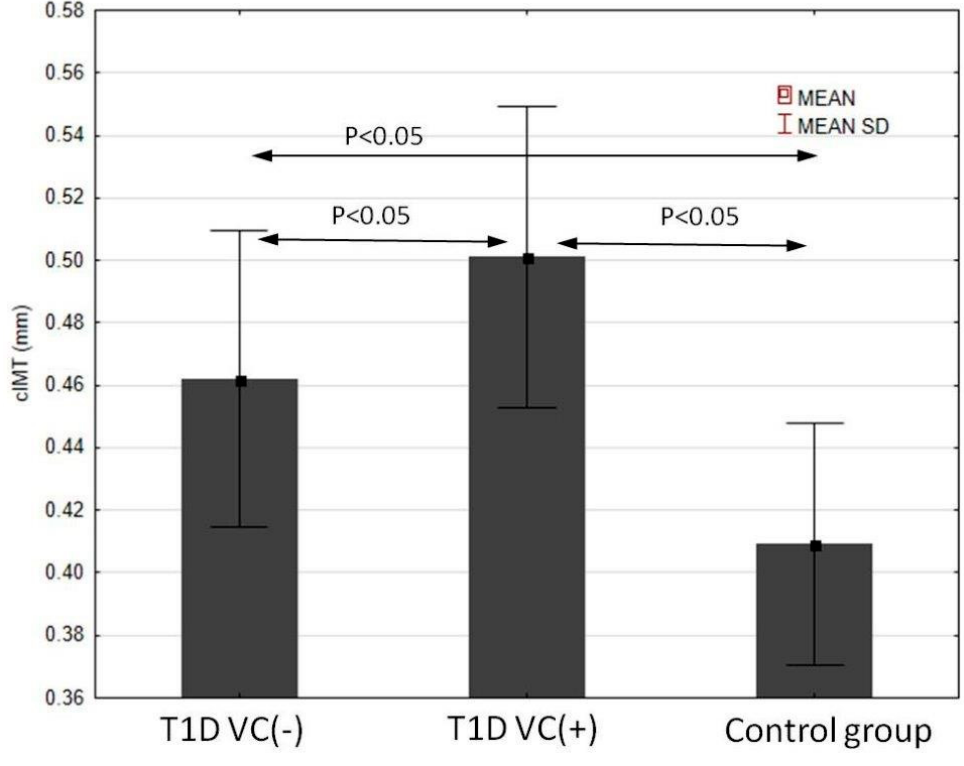
Figure 3. Carotid IMT in the studied groups.